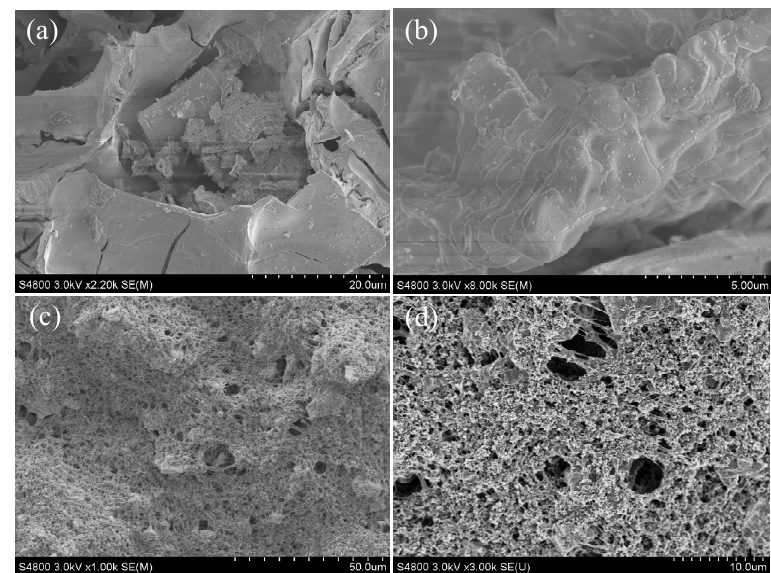
Figure 9. SEM images of ( a , b ) SrFe 0.3 Ni 0.7 O 2.85 and ( c , d ) the surface of SrFe 0.3 Ni 0.7 O 2.85 /Ti anode.